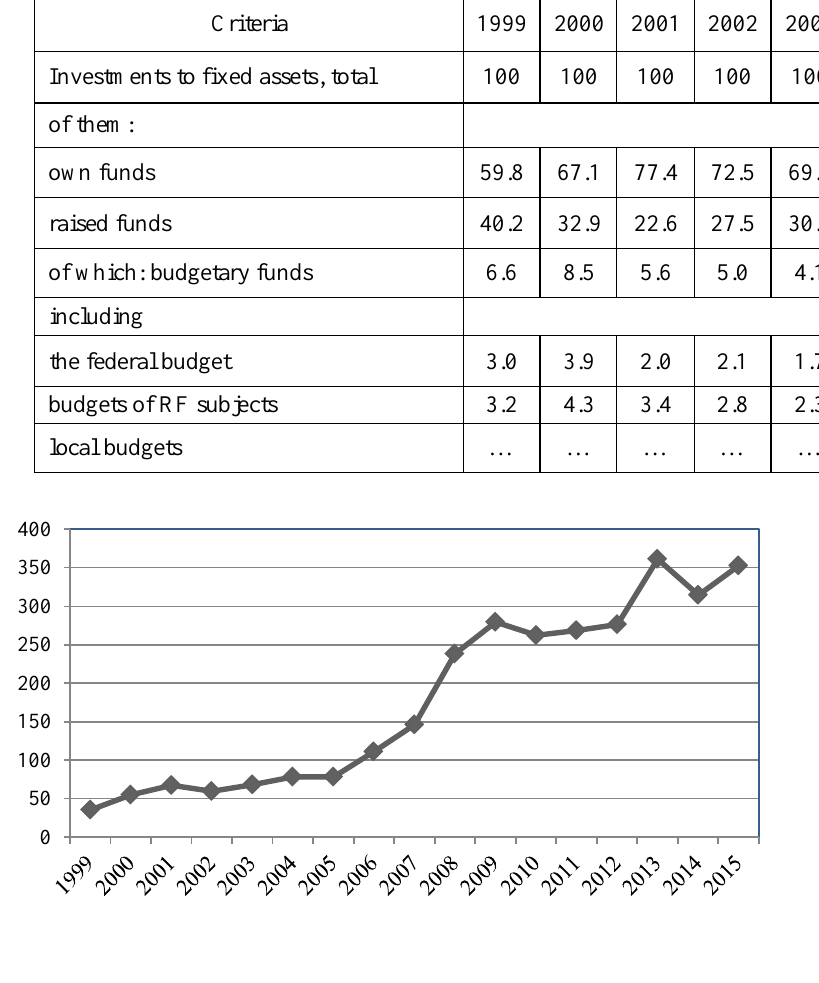
Fig. 3. Volume of the RF consolidated budget subsidies as per the item of budget classification of expenditures "Agriculture and Fishery" for 1999–2015, in bln rubles. compiled by authors to: [14]).